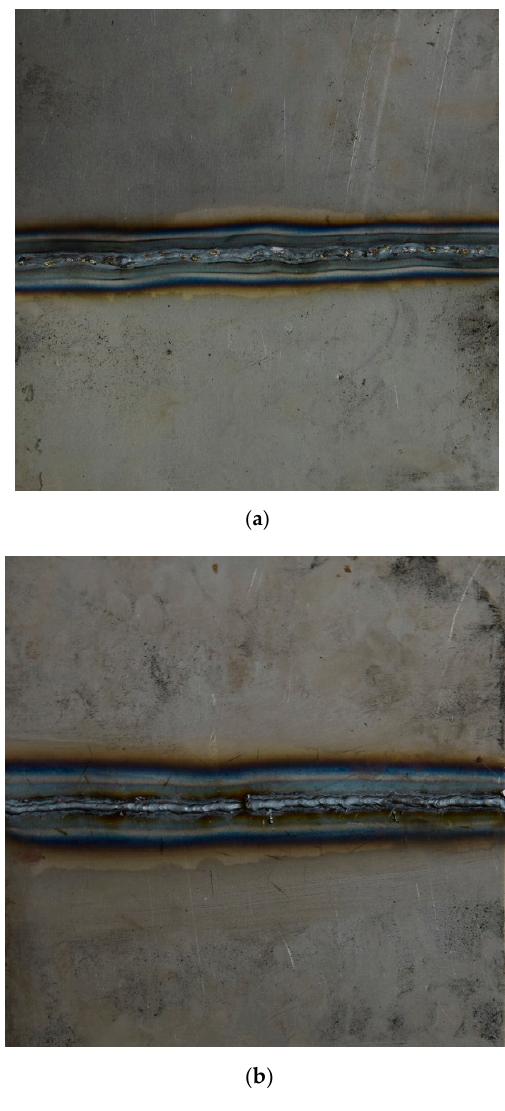
Figure 2. The TWBs after the MAG welding process ( a ) one side welded blank ( b ) double side welded blank. welded